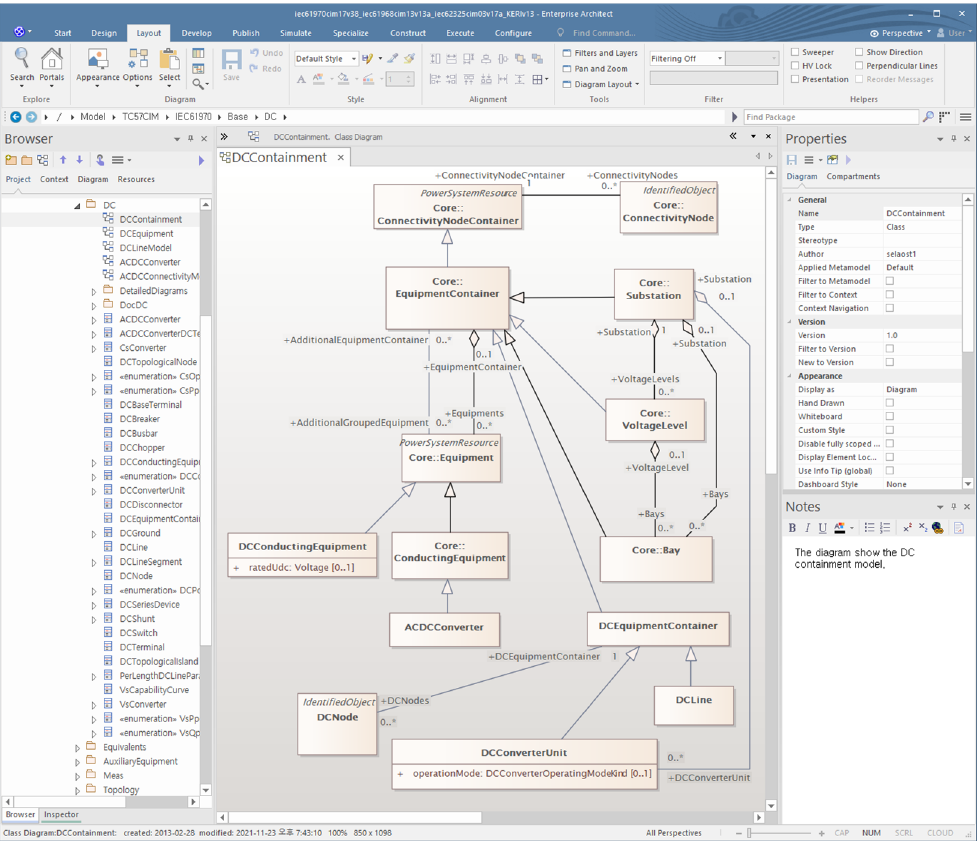
Figure 9. Creation of profiles using CIM EA. Energies 2021 , 14 , x FOR PEER REVIEW